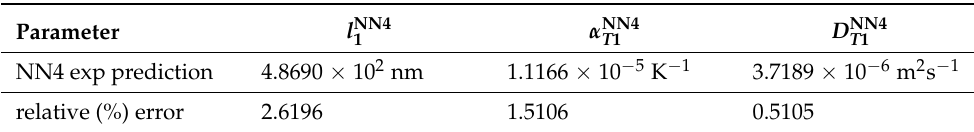
, α NN4 and D NN4 obtained by prediction of NN4, with relative (%) T 1 T 1 1